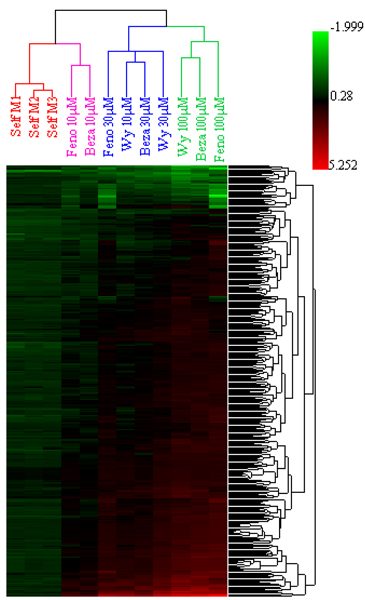
Two-dimensional hierarchical cluster analysis (HCA) of significant genes induced by bezafibrate, fenofibrate and WY-14,643.